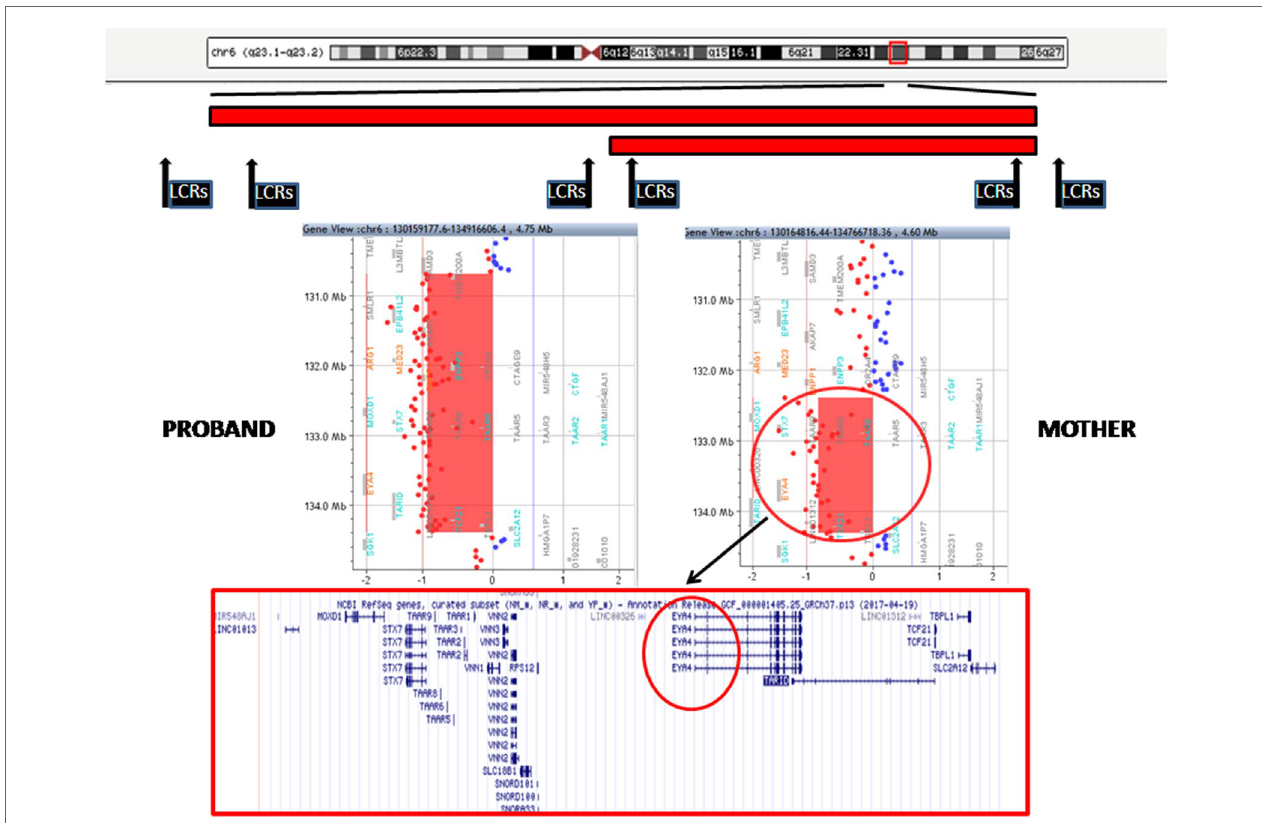
FIGURE 3 | Top: A schematic representation of chromosome 6 with the regions deleted in the proband and her mother (red bars). The position of low copy repeats (LCRs) is indicated by black rectangles. A detail of the array CGH results of the proband (left) and her mother (right) is shown in the middle panels: the genes harbored in the minimal deleted region are reported in the lower panel ( EYA4 is highlighted in black